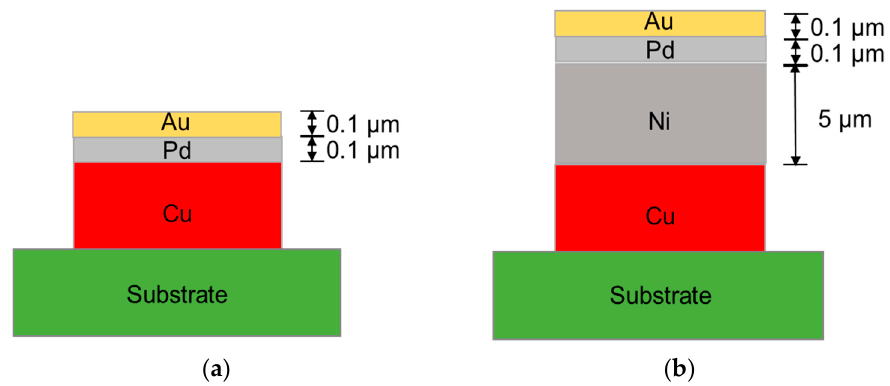
Figure 3. Schematics of the surface finishes; ( a ) electroless palladium immersion gold (EPIG) and ( b ) electroless nickel electroless palladium immersion gold (ENEPIG).